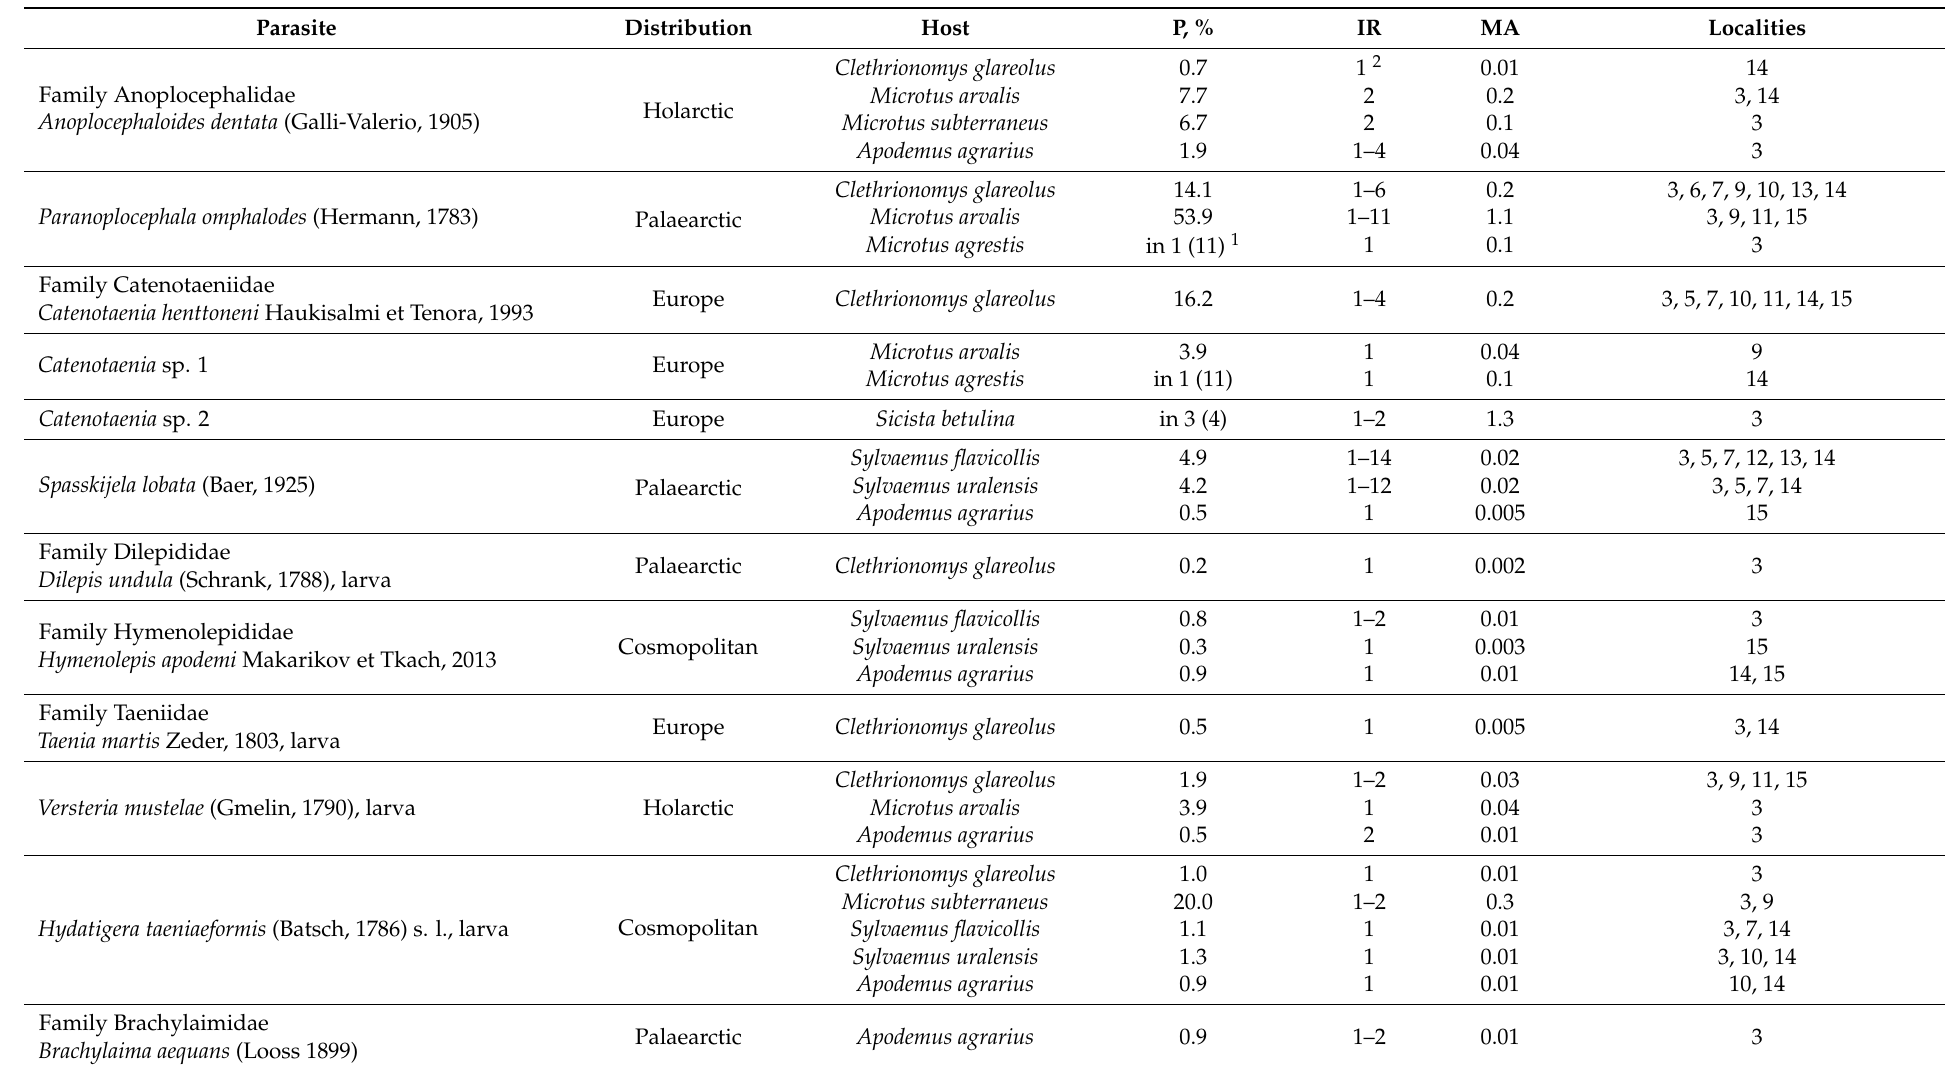
Table 2. List of identified helminth species and their distribution among myomorph rodent hosts from the National Park “Smolny” (2018–2020). Parasite Distribution Host P,